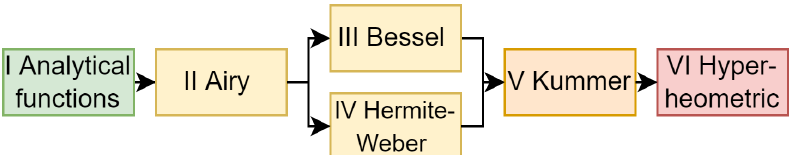
Figure 6. Scheme of the solution of the Painlevé transcendent “complexity”. Each class of functions contains the previous one. The color coding indicates the predicted relative “performance” of a conventional solver for each